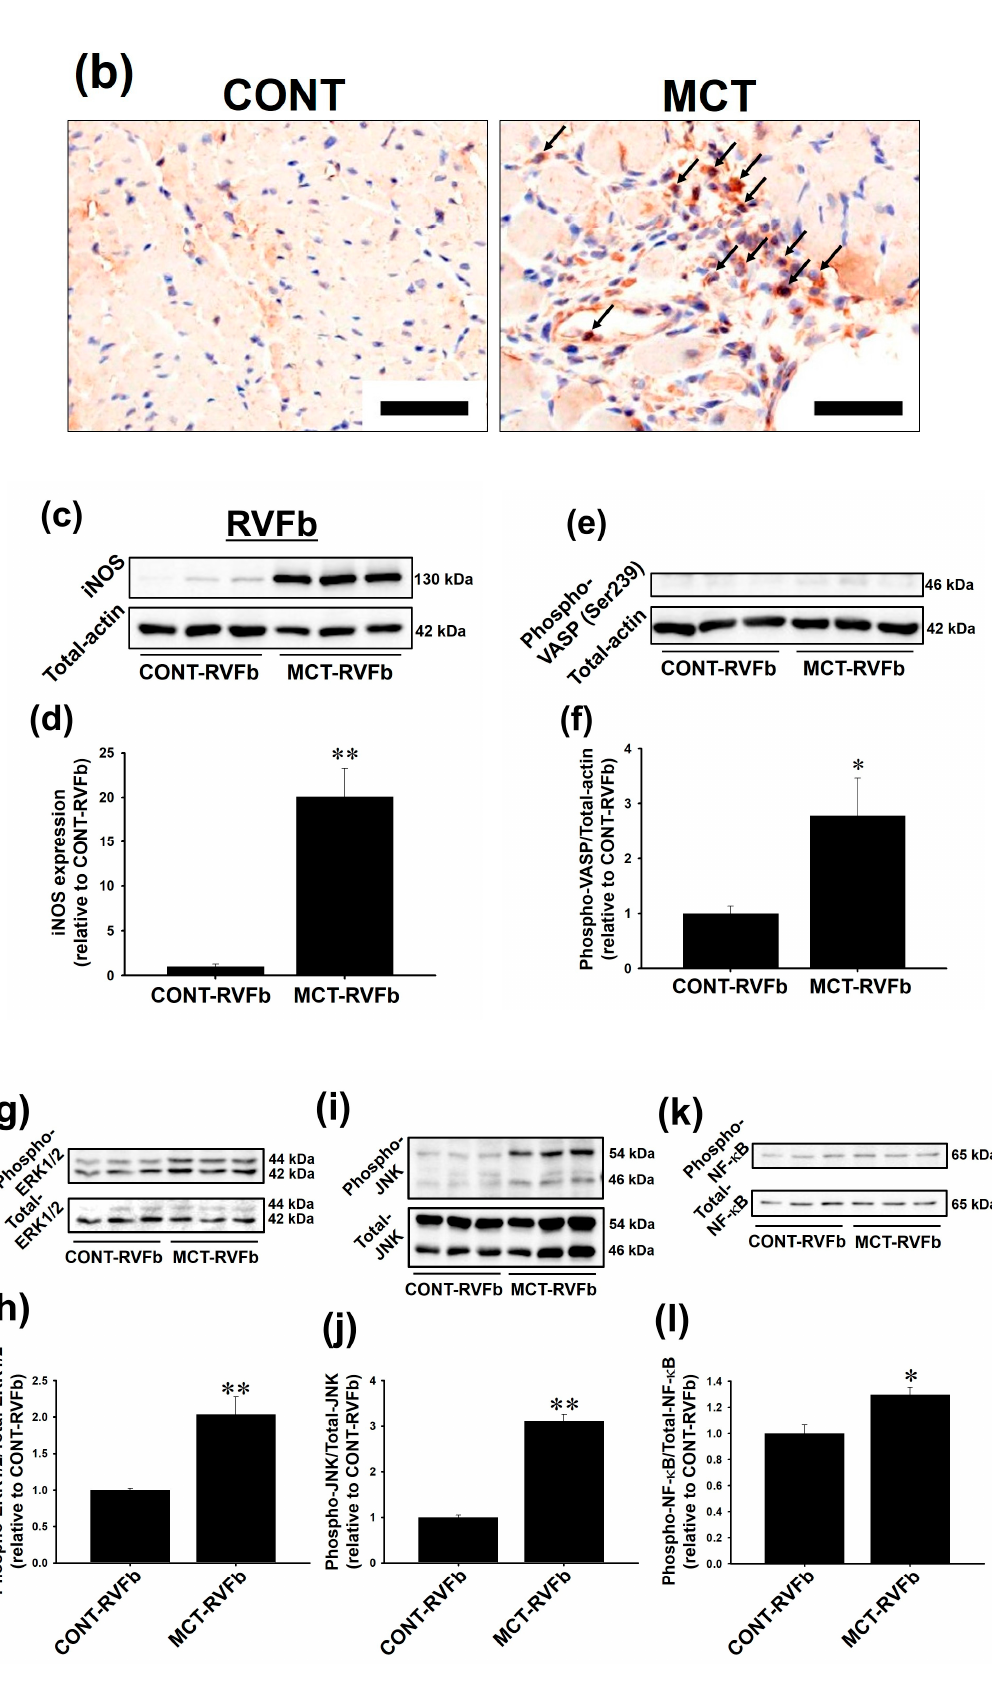
Figure 2. Protein expression of inducible nitric oxide (NO) synthase (iNOS) and phosphorylation of vasodilator-stimulated phosphoprotein (VASP), extracellular signal-regulated protein kinase 1/2